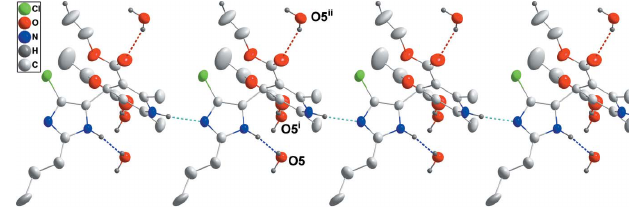
Figure 2 Detail of the chain formed by N—H (cid:2)(cid:2)(cid:2) N hydrogen bonds (light-blue dashed lines) and the surrounding sets of O—H (cid:2)(cid:2)(cid:2) O bonded (red dashed lines) water molecules [Symmetry codes: (i) x , 1 + y , z ; (ii) 1 + y , 1 (cid:5) x , 1 + z ] viewed towards (011) (the a axis extends horizontally to the right). 4